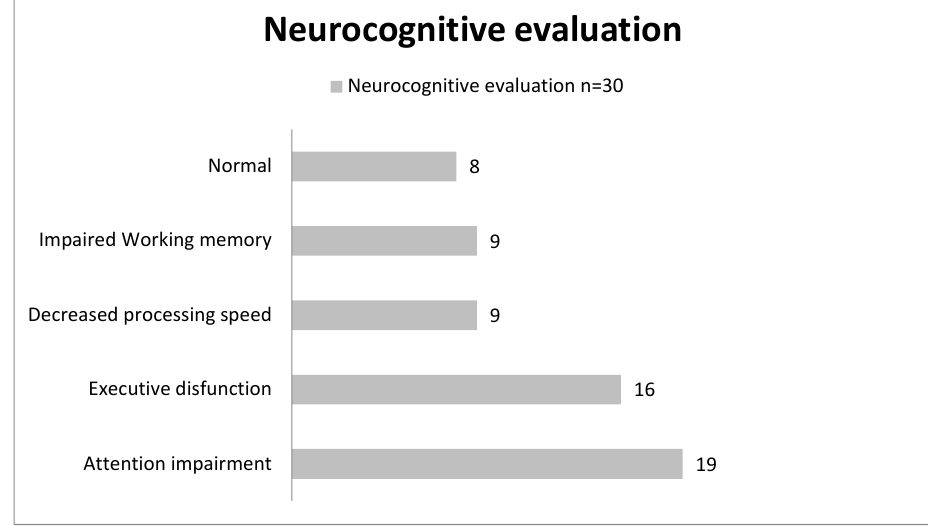
Figure 2. Neurocognitive test results ( n = 30). The bars represent the percentage of the sample with an altered test. A total of 21 (42%) CYP who were reported with a positive score on the PSC scale were referred for further evaluation by a mental health professional.